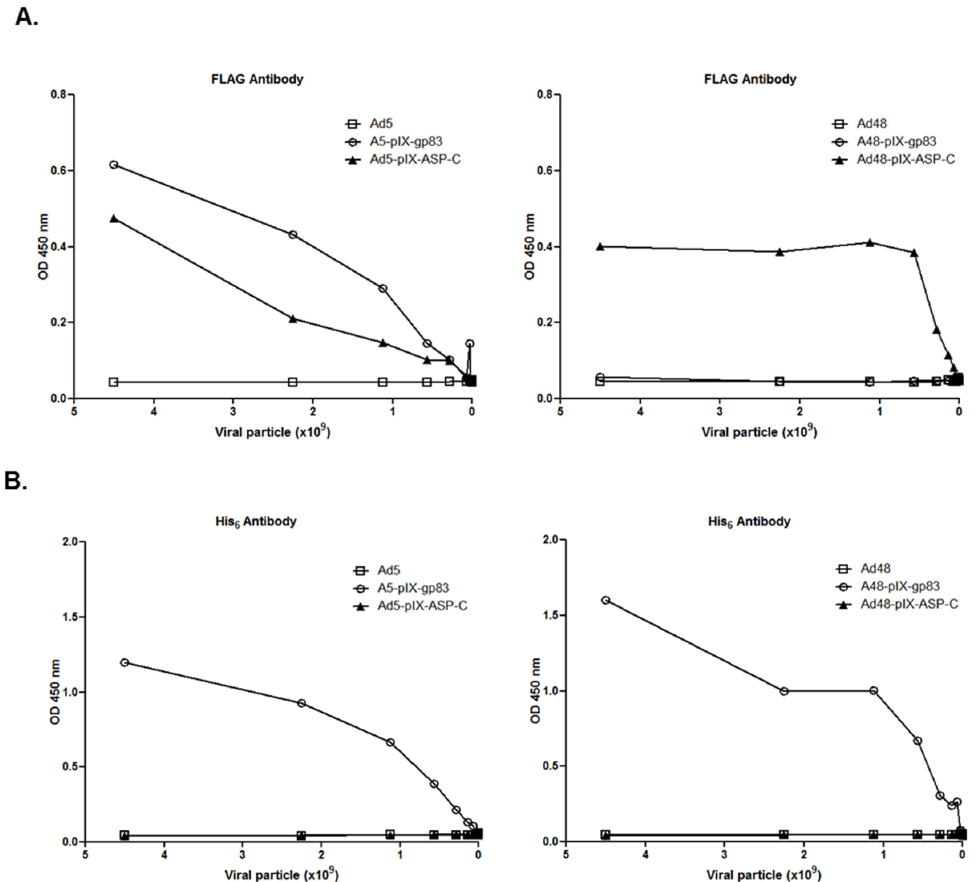
Figure 3. T. cruzi antigens are exposed on the virion surface. ( A ) Varying amounts (starting at 4.5 × 10 9 VP/mL) of purified vectors were immobilized onto the wells of ELISA plates and incubated with FLAG-HRP antibody; ( B ) Varying amounts (starting at 4.5 × 10 9 VP/mL) of purified vectors were immobilized onto the wells of ELISA plates and incubated with His 6